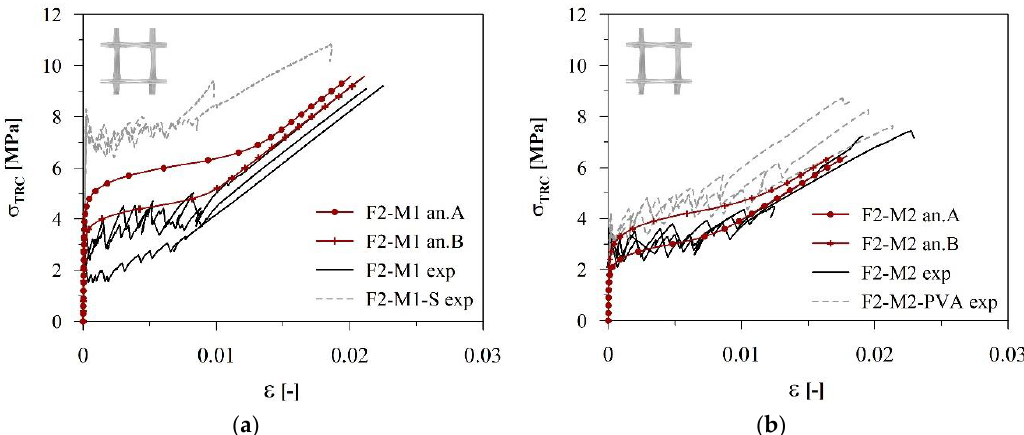
Figure 17. Comparison between the predicted analytical curves and the experimental responses in terms of nominal stress vs. strain for M1-based ( a ) and M2-based ( b ) composites reinforced with Fabric F2.